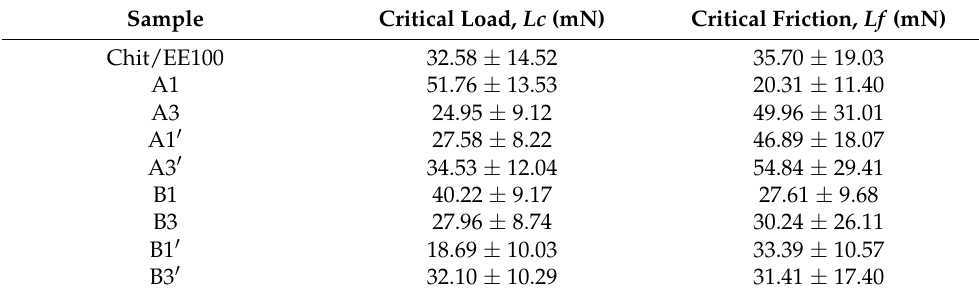
Table 4. Scratch test properties of the chit/EE100 and chit/EE100/AgNPs coatings (mean ± SD; n =